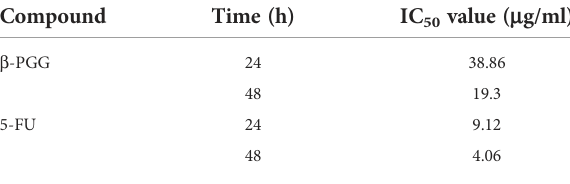
TABLE 3 IC 50 values of compounds on SGC7901